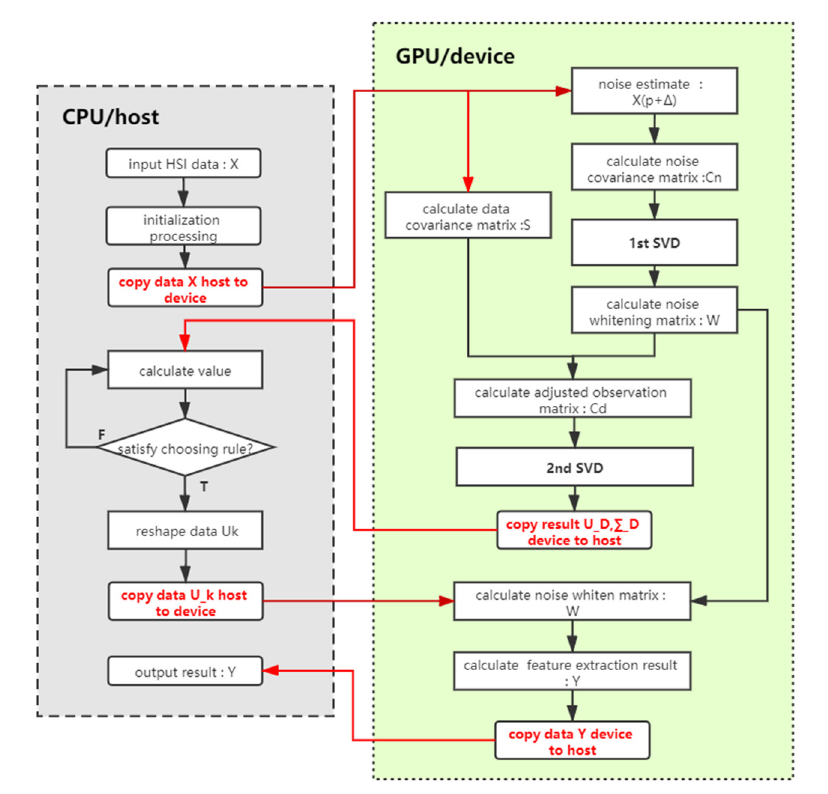
Figure 3. Flowchart of the proposed INAPC algorithm parallel implementation.